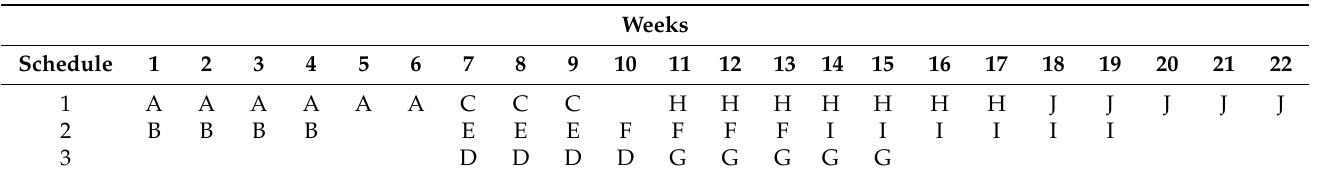
Table 4. Identification of project schedules.